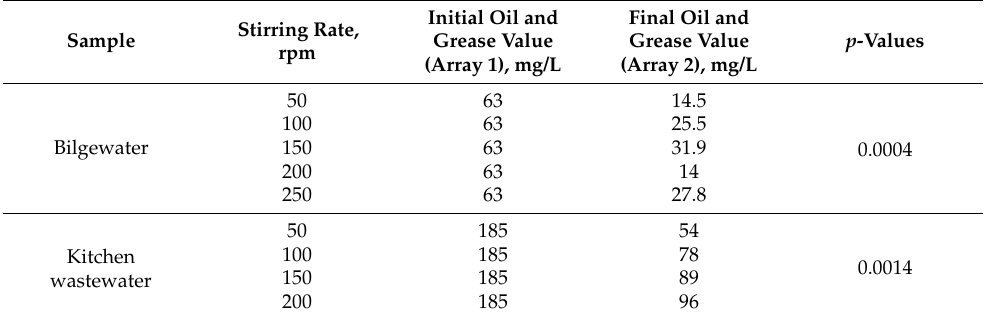
Table 5. Initial and final oil and grease values at different stirring rates and p-values obtained.